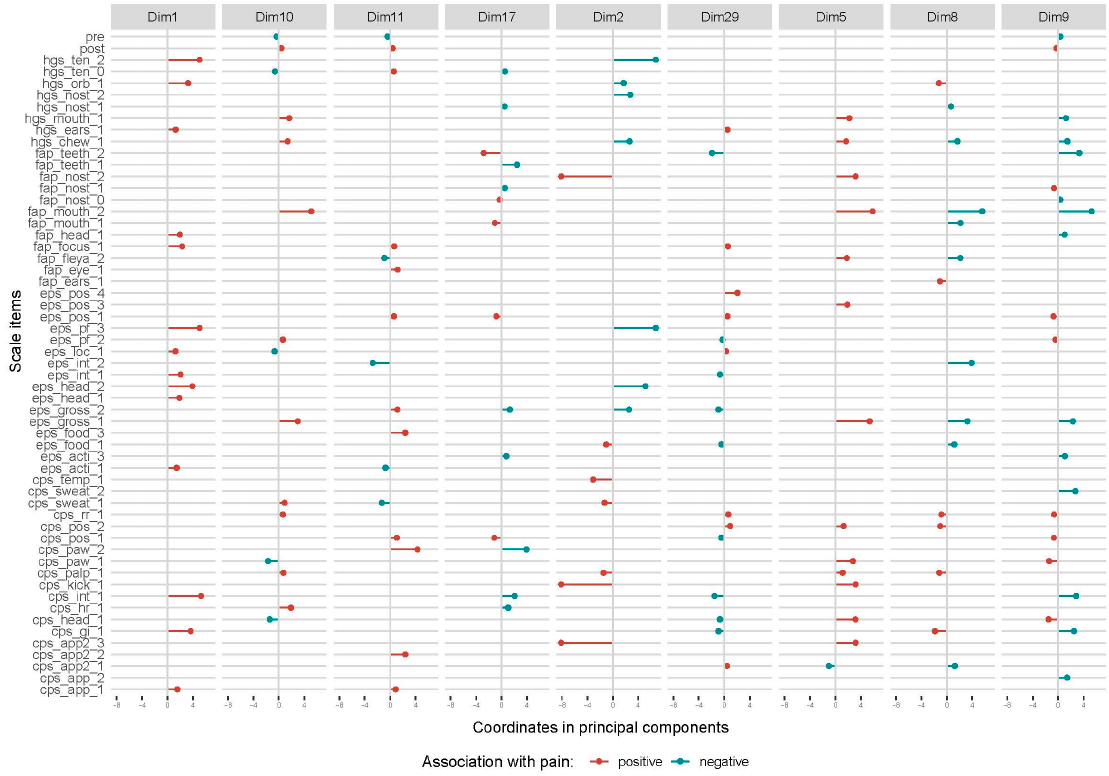
Figure 7. Results of multiple component analysis (MCA) illustrating the most significant dimensions. All scale items are included. The variance explained by each dimension is stated in the diagram. Items with red markers have a positive association with total asymmetry score, while items with blue markers have a negative association.